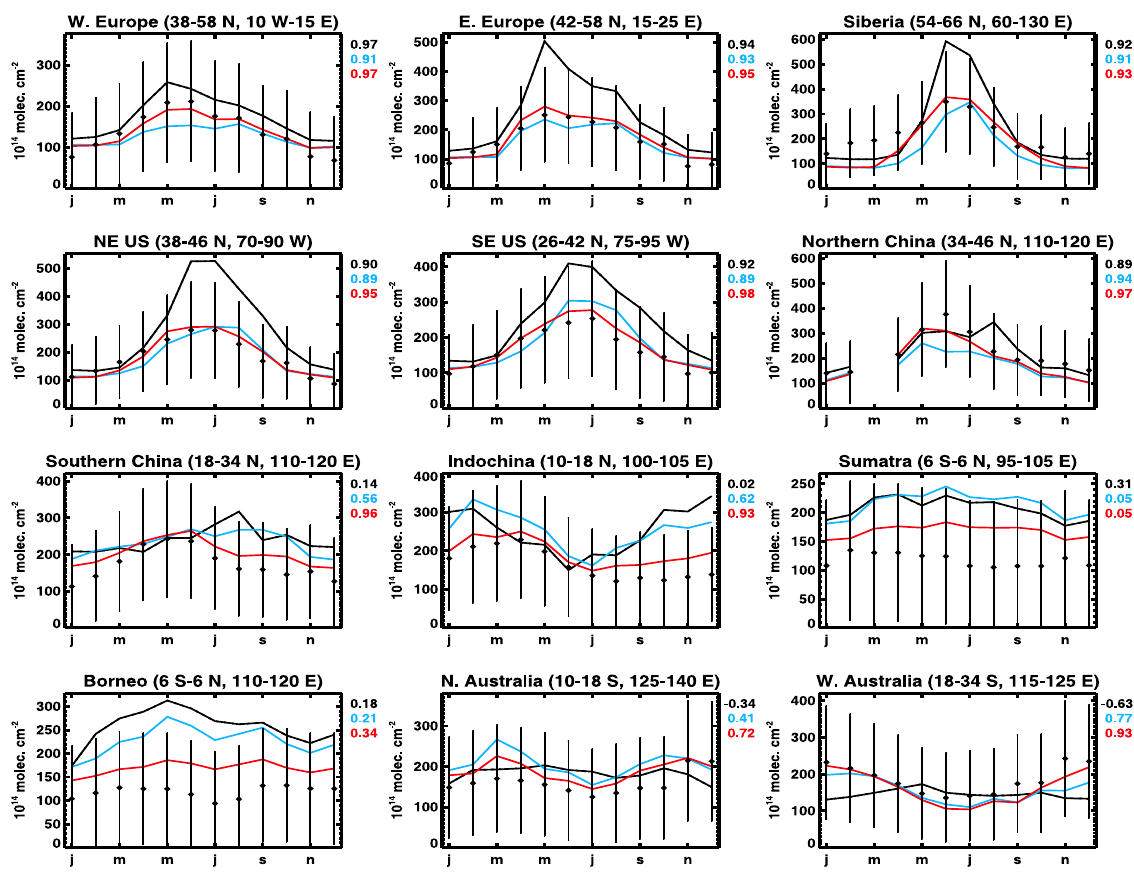
Fig. 5. Comparisons over selected regions between monthly averaged IASI methanol columns (black diamonds) with modelled columns of the S1 (black), S2 (blue), and OptS2 (red) simulations of Table 1. Numbers in the right end of each plot correspond to the correlation coefficients calculated for each simulation.